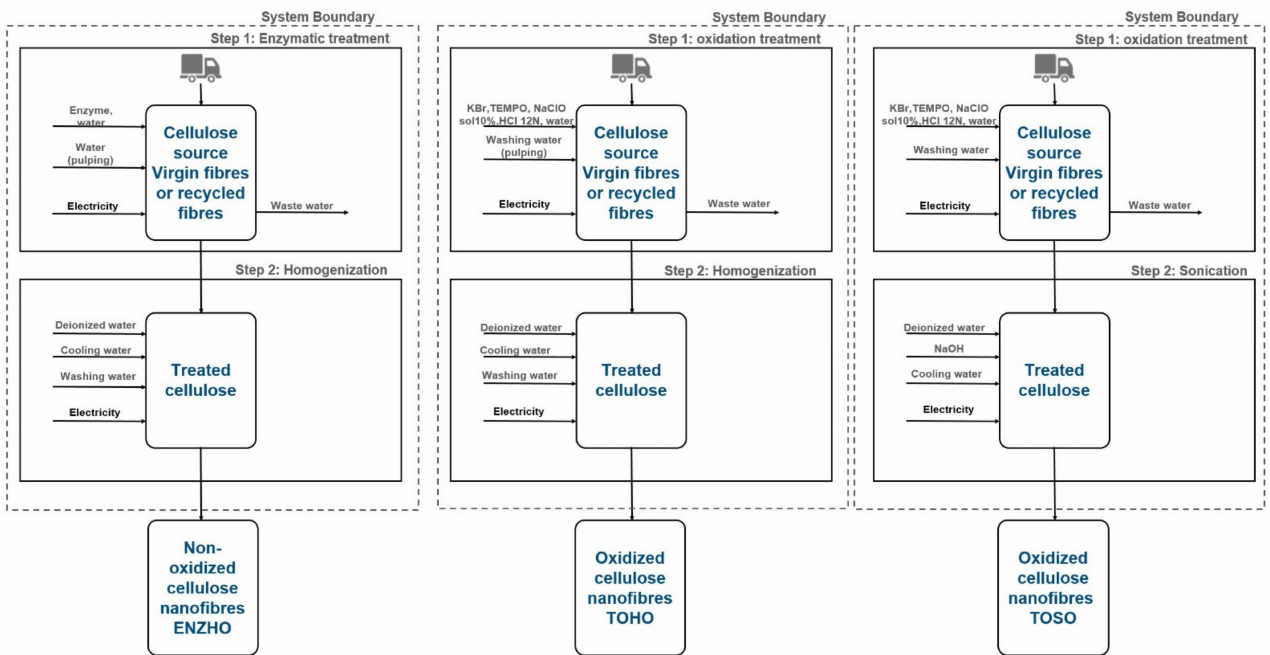
Figure 6. System boundaries of the three production processes: ENZHO, TOHO, and